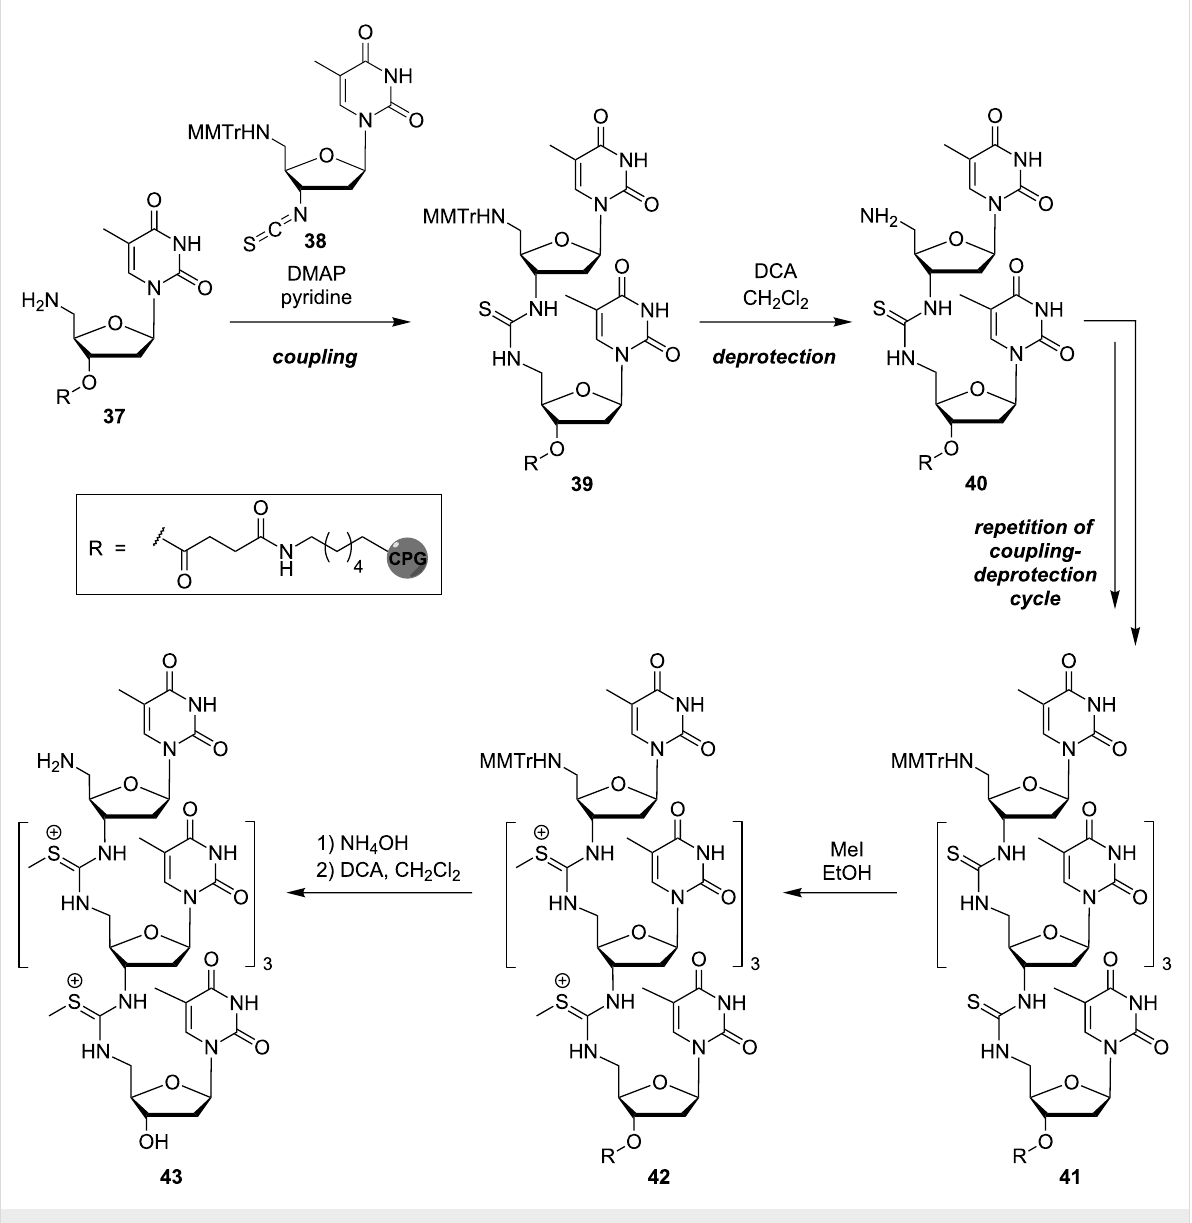
strength. This indicates a pronounced destabilization of the DNmt-DNA complex with increasing ionic strength